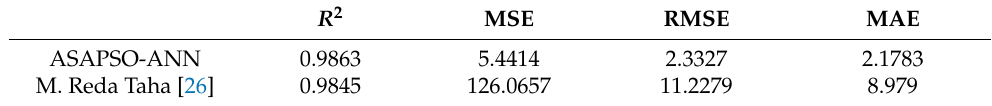
Table 6. Metrics for empirical formula and ASAPSO-ANN models.